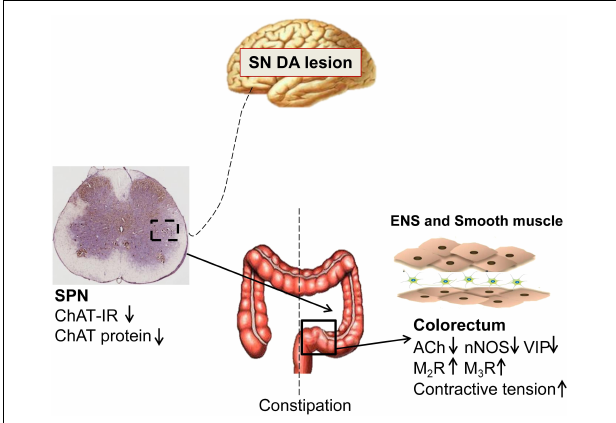
FIGURE 6 | Schematic model of the pathogenesis of constipation in 6-OHDA rats. The number of cholinergic neurons and expression of choline acetyltransferase (ChAT) protein in the sacral parasympathetic nuclei (SPN) was decreased in rats with central nigrostriatal dopaminergic denervation. Decreased expression of nNOS and VIP in the colorectum might be primarily responsible for the increased colorectal contractile tension and outlet obstruction constipation. Meanwhile, the impaired cholinergic transmission and upregulation of M2/M3 might also partially involve in the colorectal